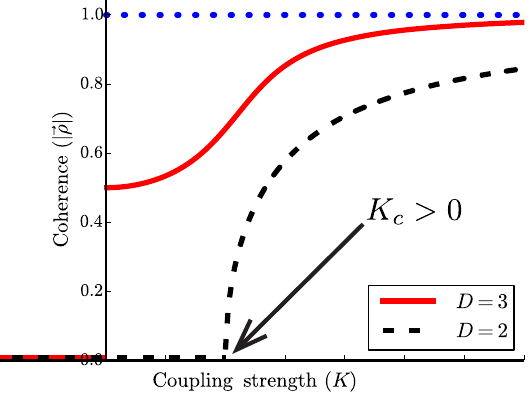
FIG. 1. Phase transitions for the standard two-dimensional Kuramoto model from theory (see Ref. [31]), shown as the black dashed curve, and for the Kuramoto model generalized to three dimensions as calculated from the theory in Eq. (18), shown as the solid red curve. Note the continuous transition in the two- > 0 , dimensional Kuramoto model at a critical coupling of K c and the discontinuous transition of the three-dimensional Kur- 0 . The blue dotted line represents the amoto model at K c ¼ maximum possible value of coherence, corresponding to j ρ j ¼ 1